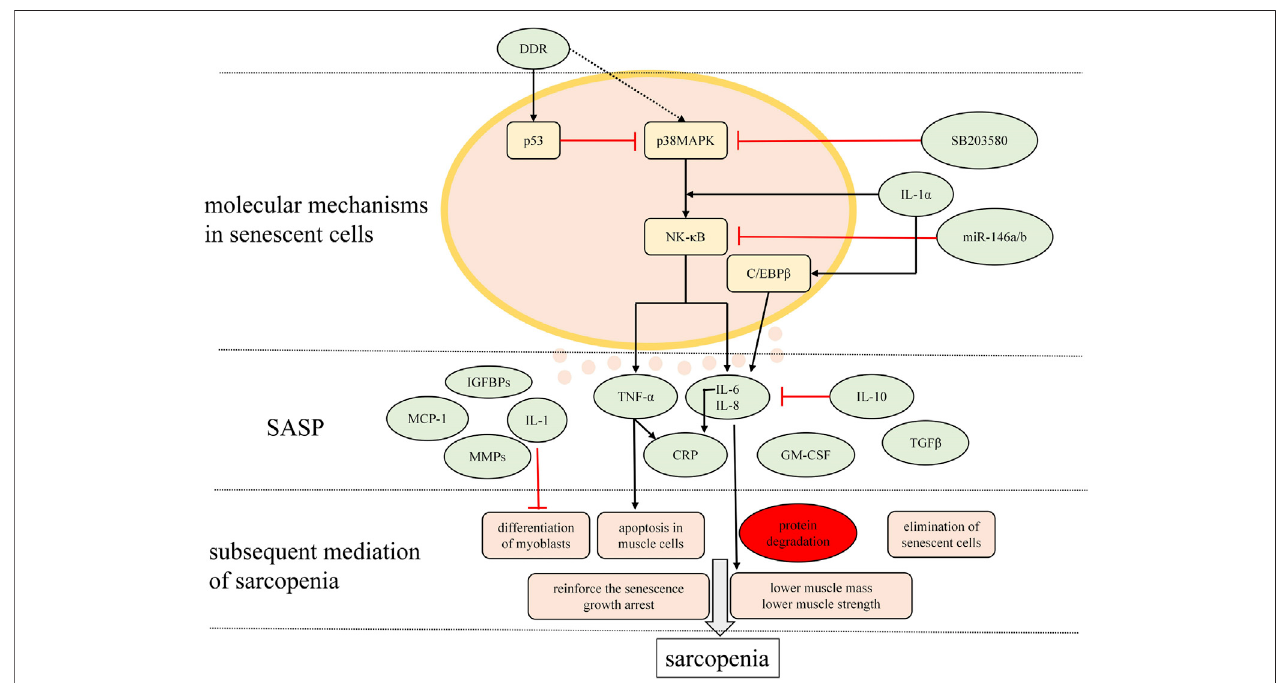
FIGURE 2 | Major signaling pathways modulating the SASP and the main charactersitics of SASP relevant to sarcopenia. Mutiple molecules are secreted by senescent cells in musculosketal microenvironmet that possibly correlate with in fl ammaging in sarcopenia are presented here.